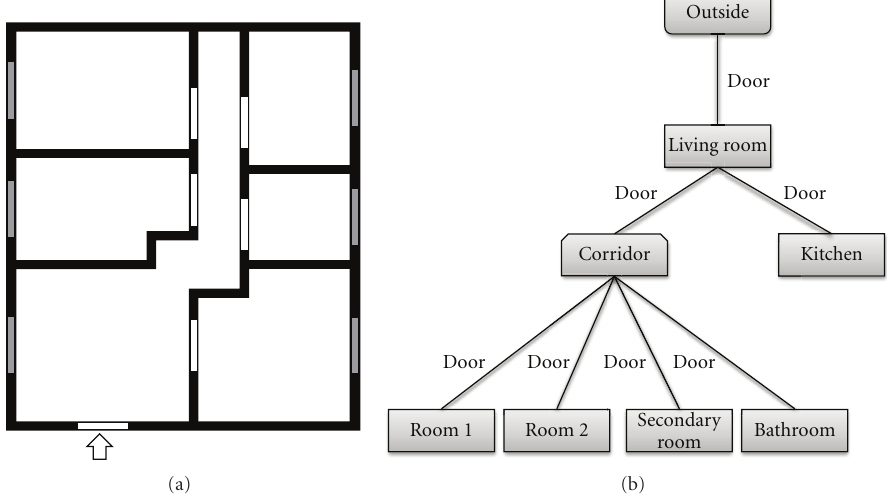
Figure 11: Example of floor plan of Figure 10 (a) containing corridors and all rooms are connected to the living room and its respective connectivity graph